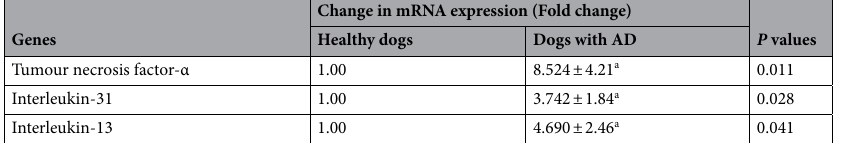
Table 3. Relative mRNA expressions of TNF-α, IL-31 and IL-13 in PBMCs of dogs with AD and healthy controls. Data presented are Mean ± SD. a Significantly higher when compared with healthy control.